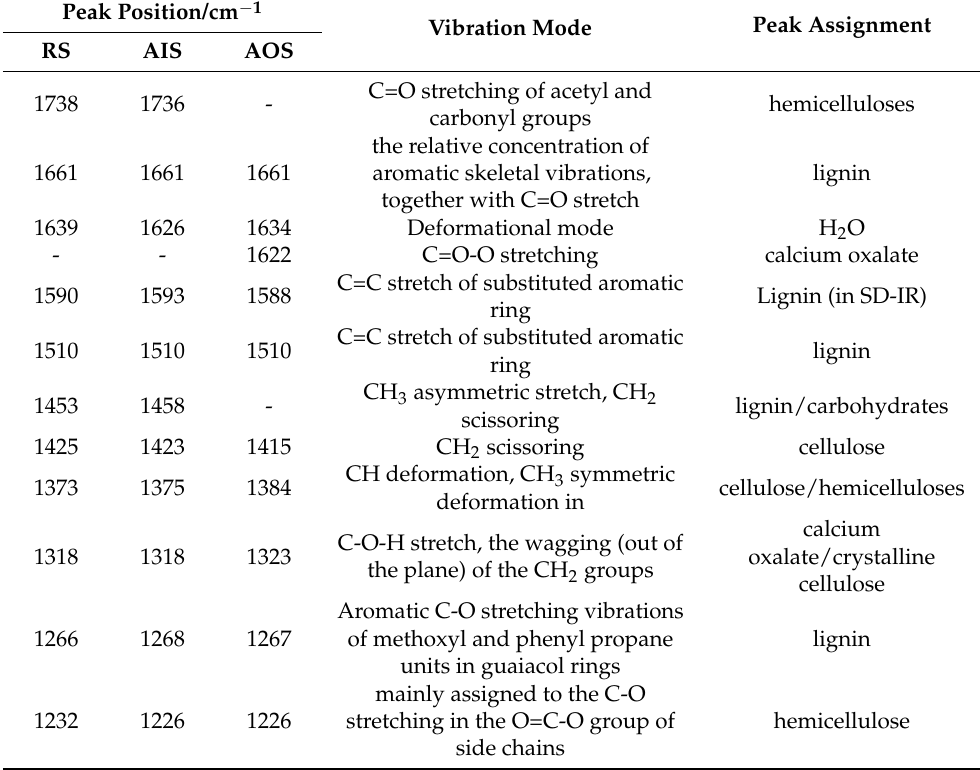
Figure 6. SD ‐ IR spectra of RS (black), AIS (red), and AOS (blue). Figure 6. SD-IR spectra of RS (black), AIS (red), and AOS (blue). Table 2. Peak assignments for the FT ‐ IR spectra of the wood samples in the fingerprint region (1800– Table 2. Peak assignments for the FT-IR spectra of the wood samples in the fingerprint region 800 cm − 1 ) [4,42,45,62,63]. (1800–800 cm − 1 )